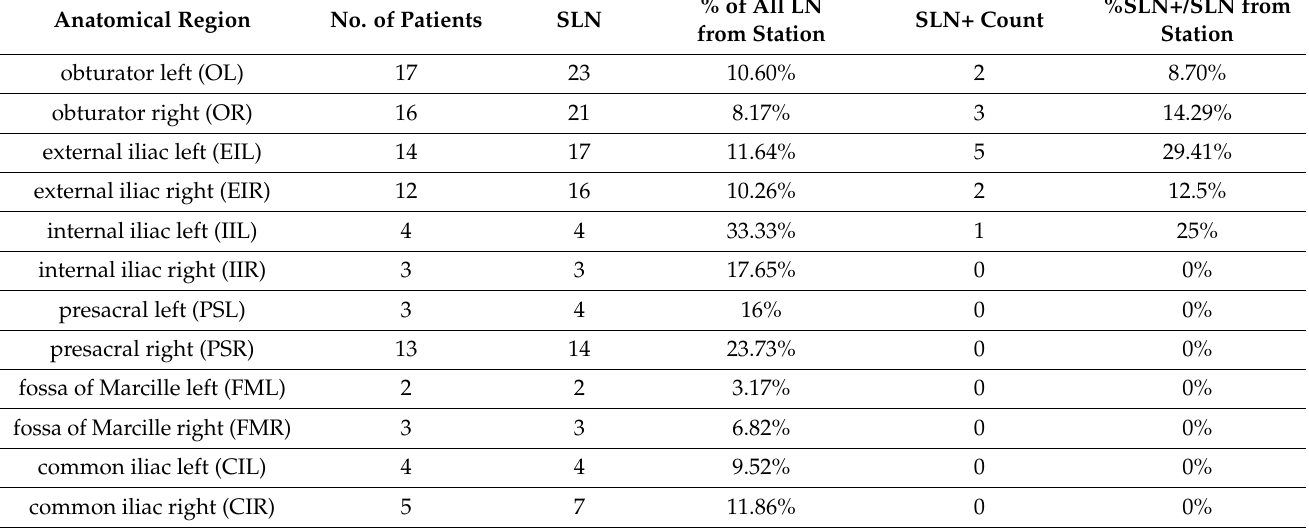
Table 4. Characteristics of the removed sentinel nodes from individual anatomical